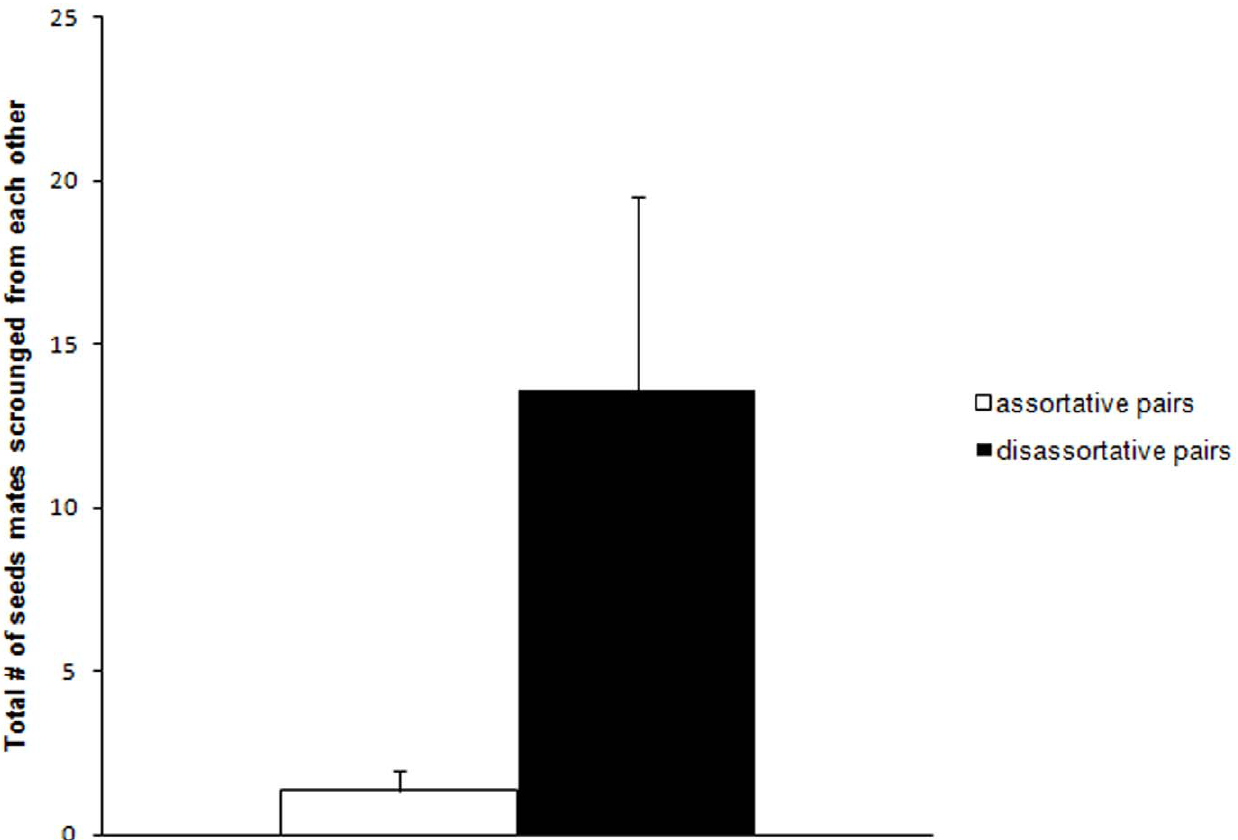
Figure 5. Total number of seeds mates scrounged from each other in assortative pairs (mean ± SE, N =10, white bar) and disassortative pairs ( N =11, black bar).